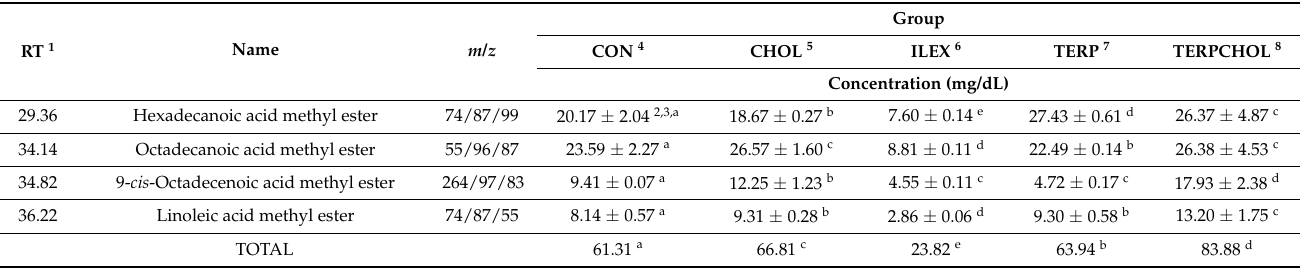
Table 11. Fatty acid profile of blood serum in normal or hypercholesterolemic Wistar rats after treatment with I. aquifolium and terpenoid